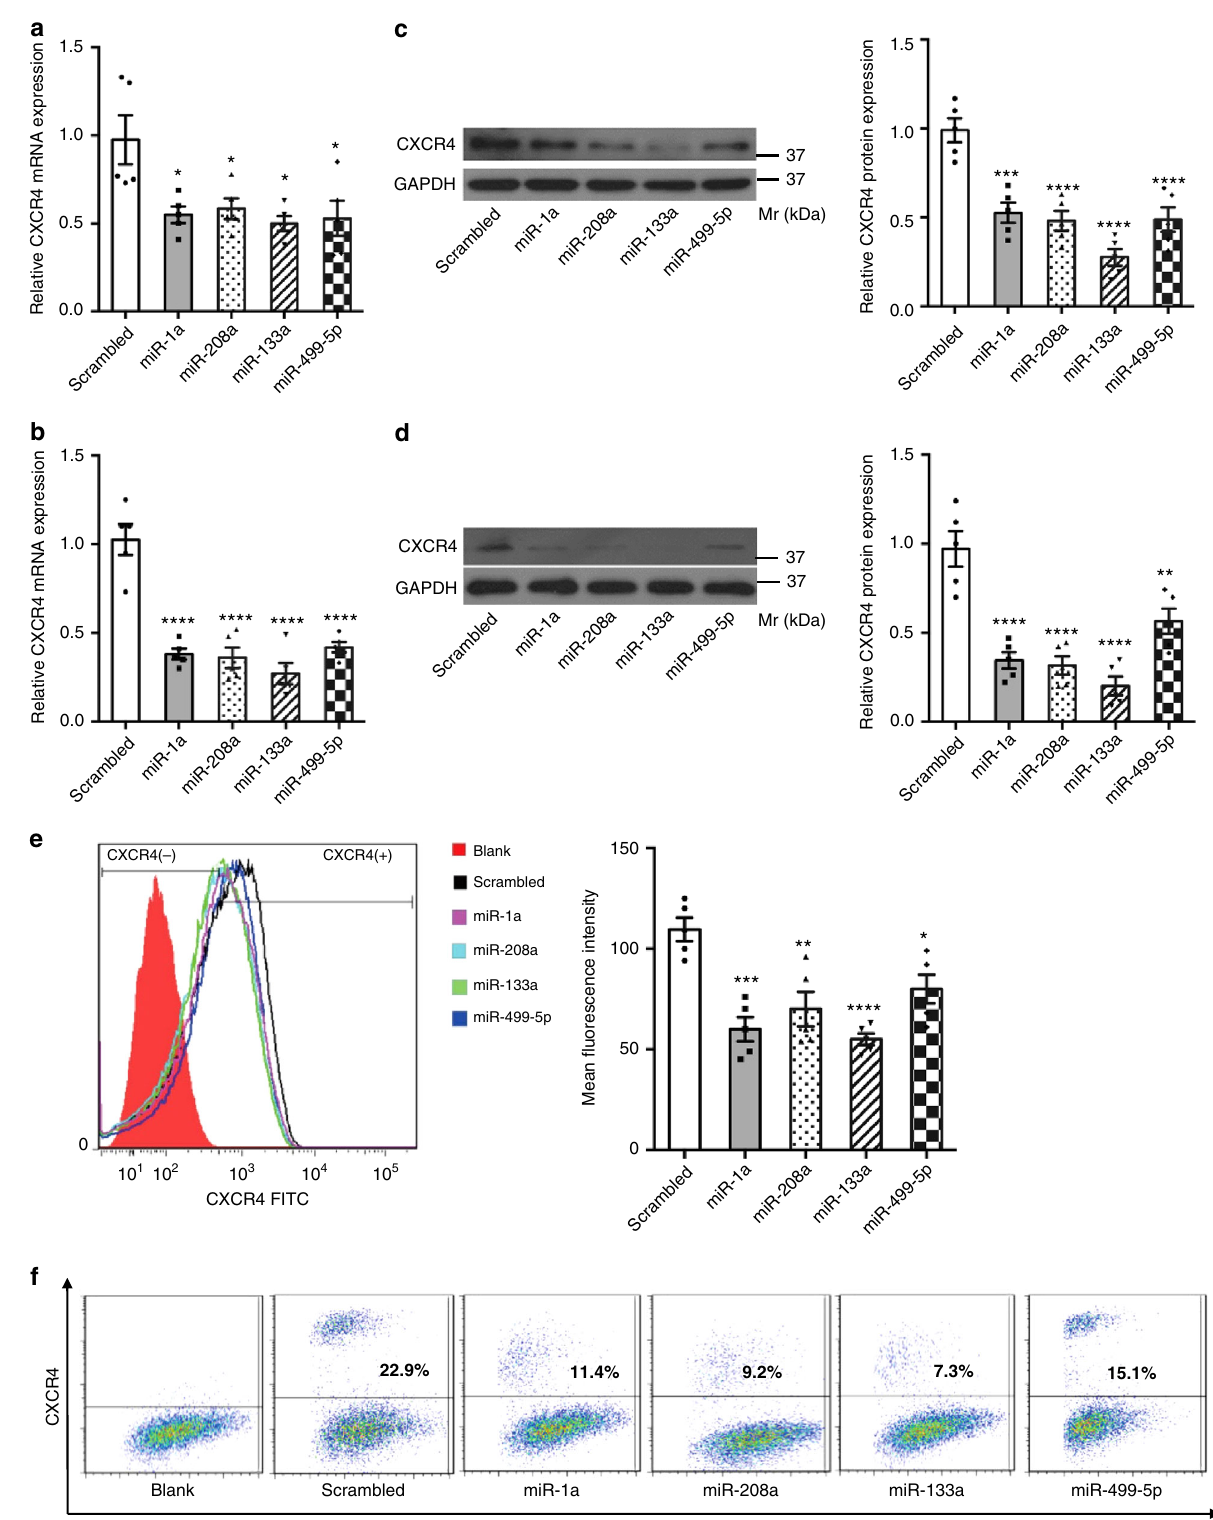
Fig. 3 Myo-miRs downregulate CXCR4 expression in BM-MNCs and MSCs in vitro. BM-MNCs (2 × 10 6 /well) and MSCs (0.5 × 10 6 /well) were transfected with synthesized miR-1a, miR-208a, miR-133a, or miR-499-5p mimics or with a scrambled miR ( fi nal concentrations: 50 nM); 24 h later, CXCR4 mRNA expression in the BM-MNCs ( a , c , e ) and MSC ( b , d , f ) was quanti fi ed by RT-PCR ( a , b ), Western-blotting ( c , d ), and fl ow cytometry ( e , f ). * p < 0.05, ** p < 0.01, *** p < 0.001, **** p < 0.0001 vs. Scrambled. n = 5 biologically independent samples per group. A one-way ANOVA was used for statistical analysis. Error bars represent mean ±